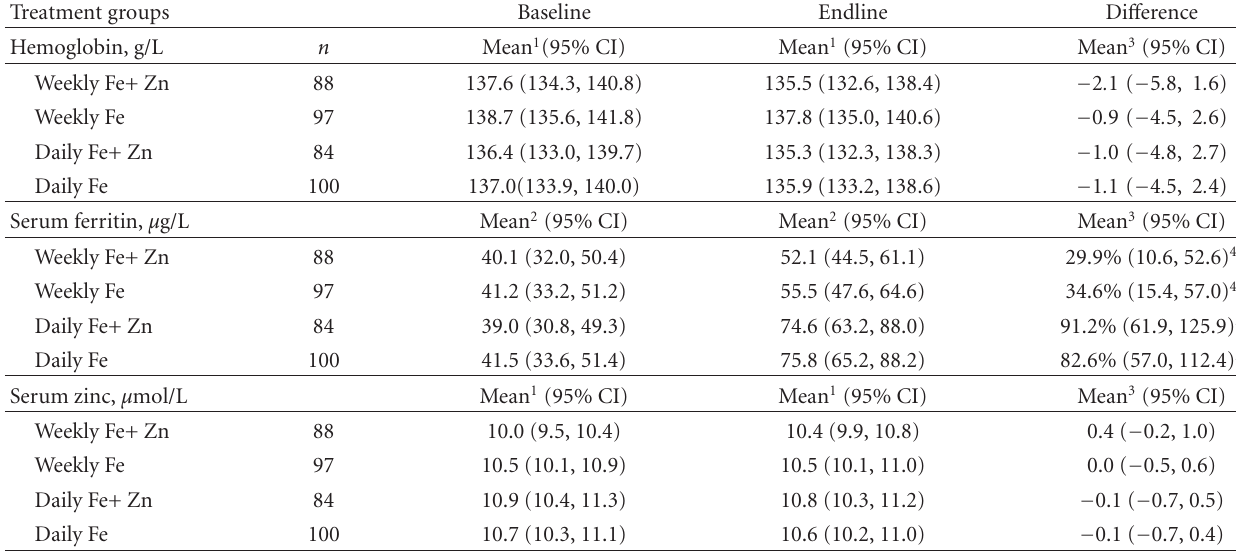
Table 2: Hemoglobin, serum ferritin, and serum zinc concentrations in women before and after daily or weekly supplementation for 12weeks ( n =